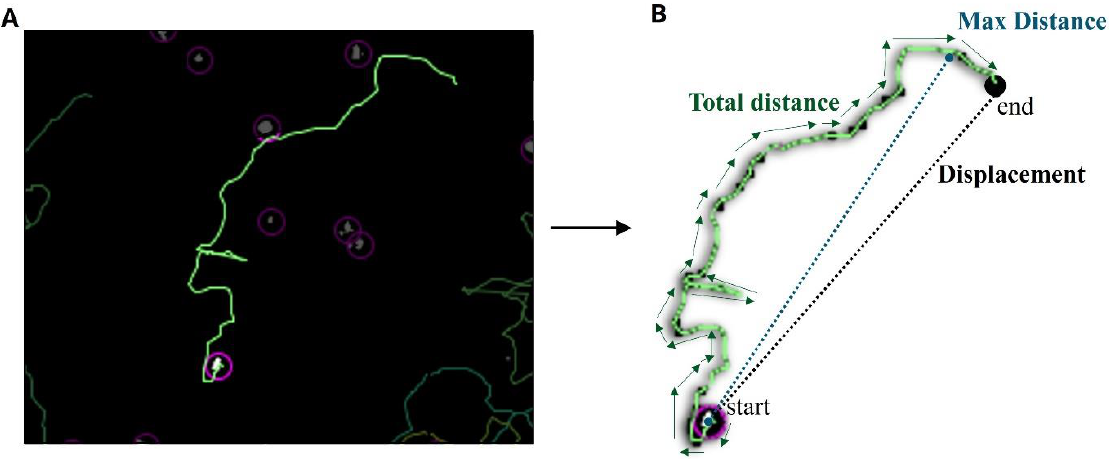
Figure 3. Representative image of track algorithms. ( A ) Original tracked image. ( B ) Representative parameters describing how total distance, max distance, and displacement are